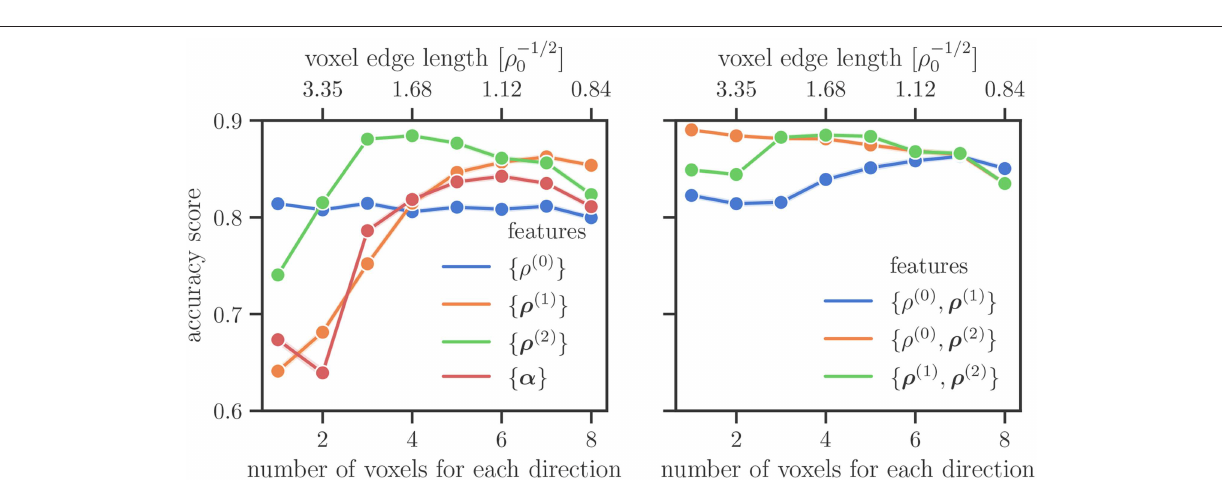
free surfaces everywhere, while the samples from the 60 nm and 90 nm specimens have only one free surface, i.e., the one with outwards normal pointing into positive x